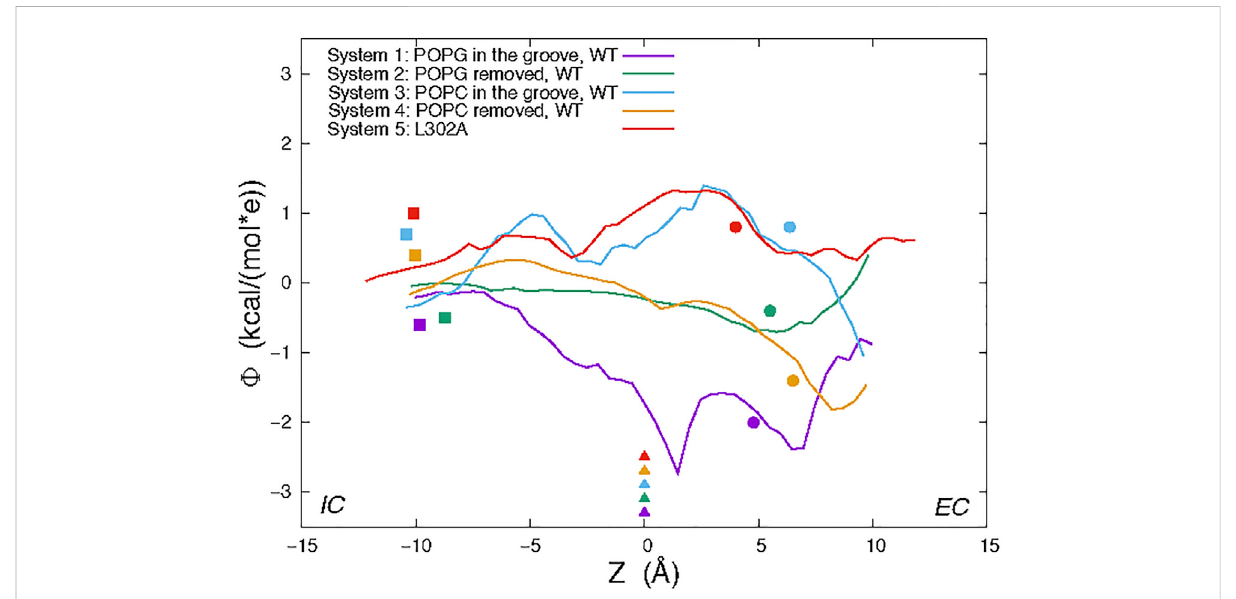
FIGURE 8 Electrostatic potential (EP) values calculated along the average trajectory of K + from umbrella sampling (see text and Figure 6) for the wild type nhTMEM16 Systems 1 – 4 and the nhTMEM16-L302A mutant. For orientation along the trajectories, the colored symbols indicate the Z positions of the following landmarks: C α atom of T381 (triangles); C α atom of Y439 (circles); the highest placed Ca 2+ ion